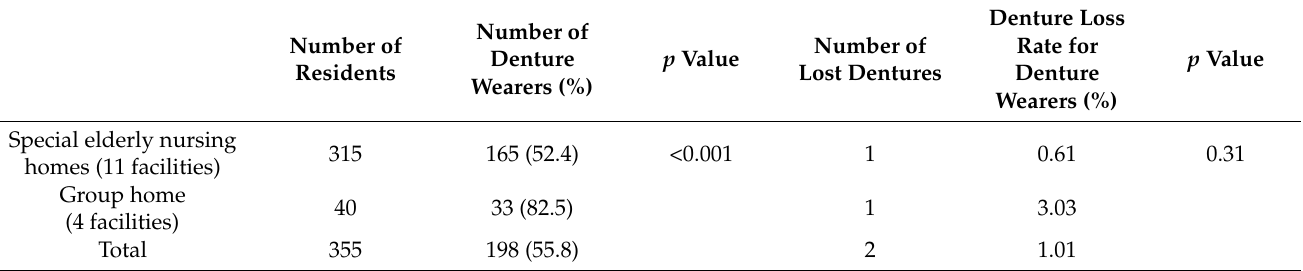
Table 1. Denture wearer rate and denture loss rate in the two types of geriatric facility.